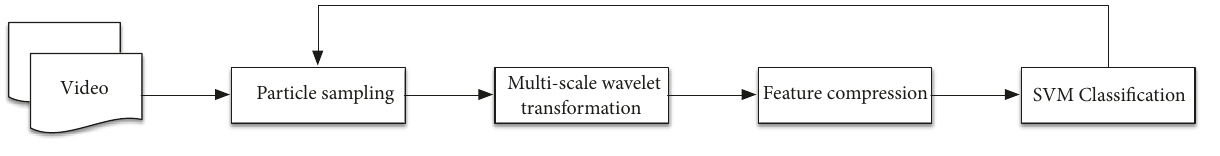
Figure 1: The flowchart of the proposed tracking method.